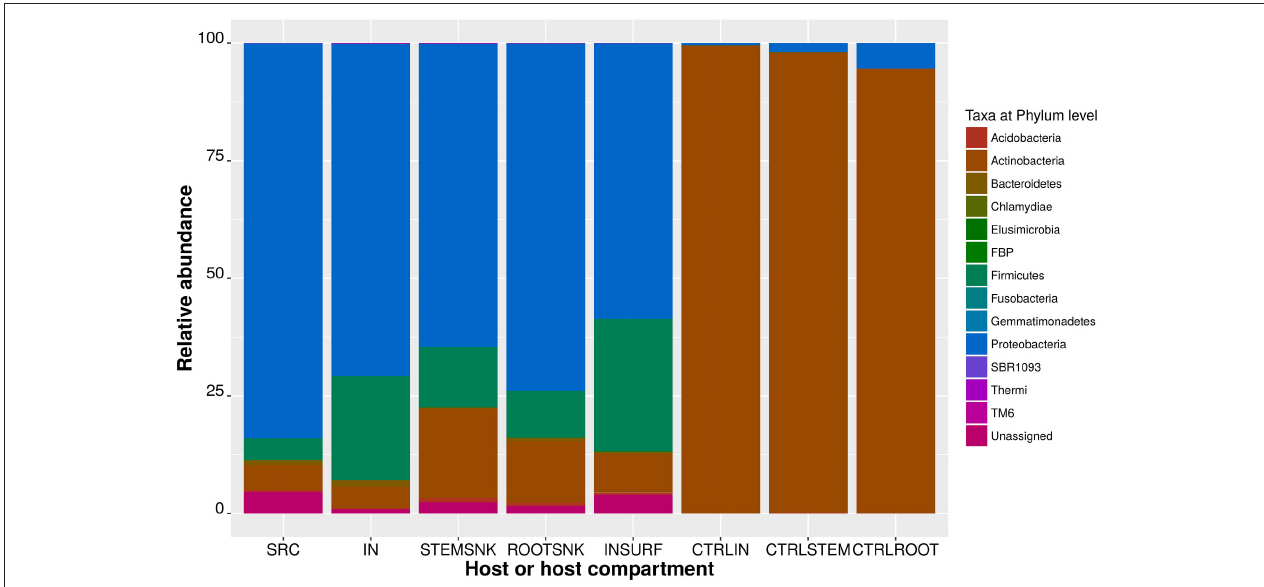
FIGURE 2 | Relative abundance of OTUs assigned at the phylum level. Stacked bar plots represent the percentages of 216 members of the OTU table in biom format. In the legend, unassigned correspond to OTUs whose taxonomy could not be clarified at the 97% confidence using the Greengenes database.